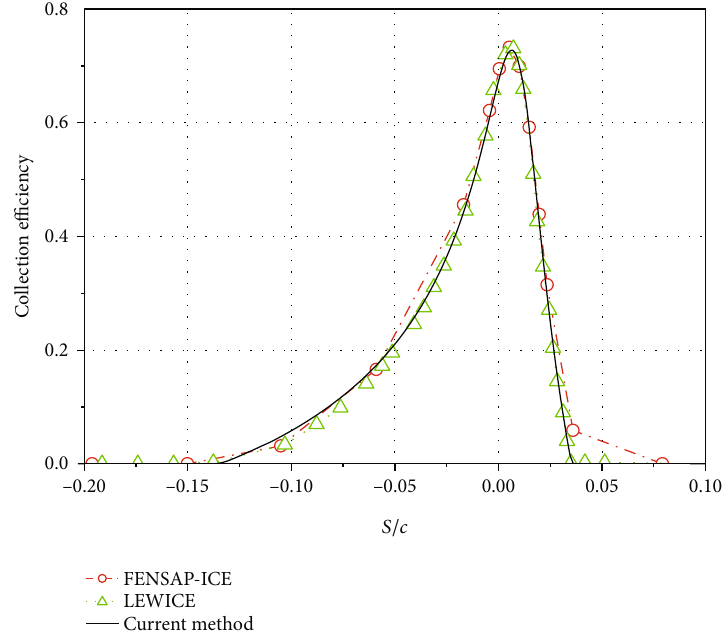
Figure 6: Comparison of collection e ffi ciency among the numerical data obtained by the current code, LEWICE, and FENSAP-ICE. Table 3: Settings for the rime ice accretion case.